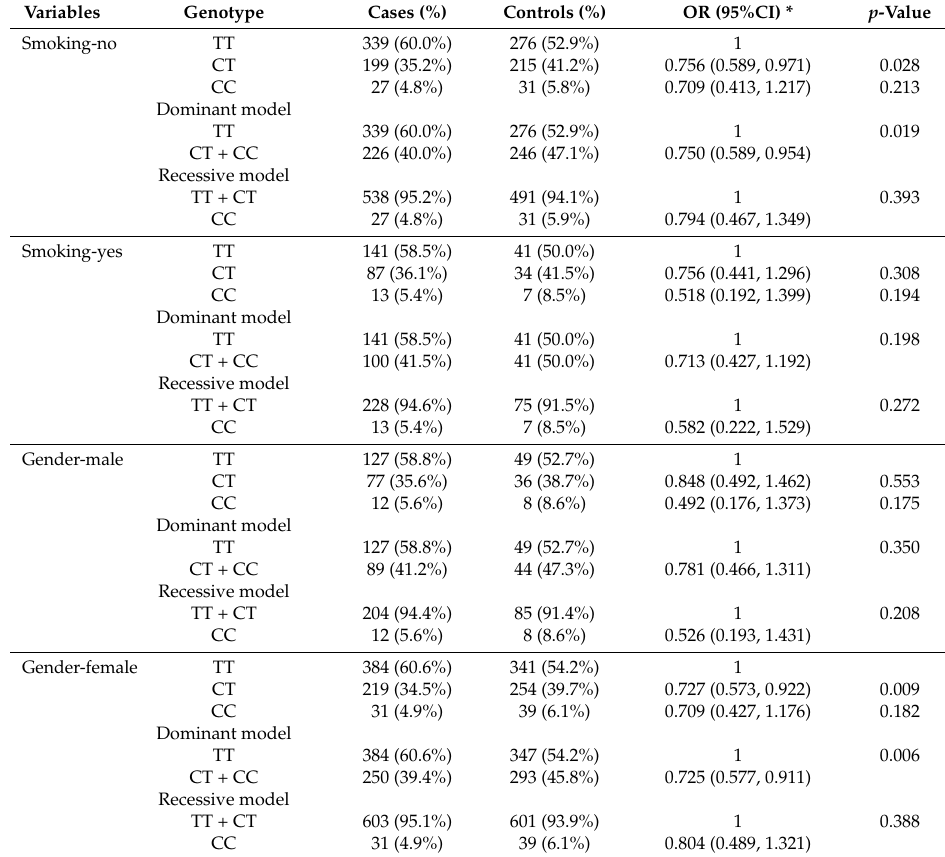
Table 4. Stratification analysis of rs1412125 polymorphisms and risk of lung cancer.